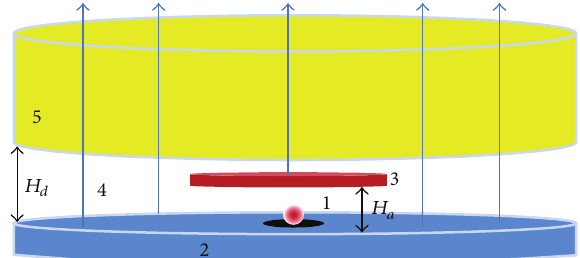
Figure 7: A sketch of the principle scheme of an experiment on magnetically induced resonant transitions between H gravitational states. 1: a source of ultracold antihydrogen, 2: a mirror, 3: an absorber, 4: a magnetic field, and 5: a detector.